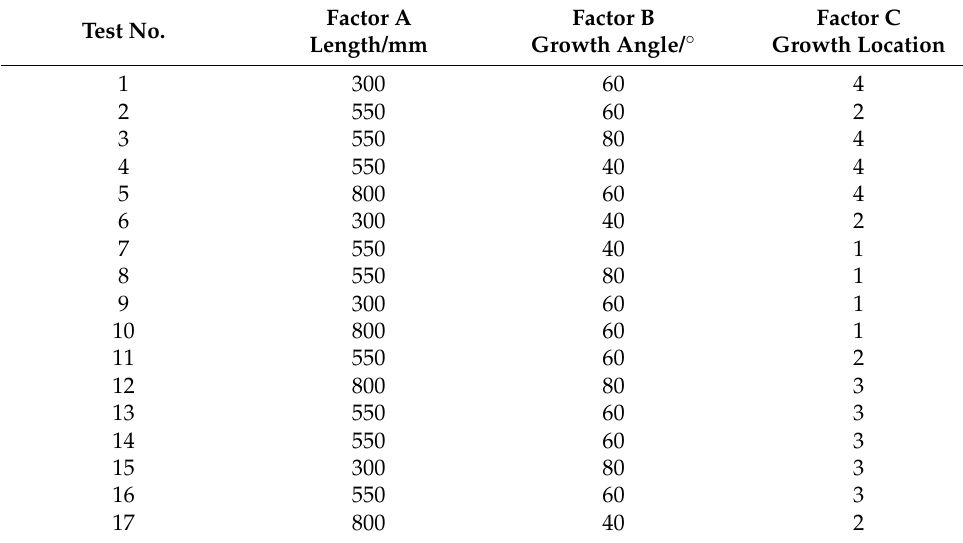
Table 2. Orthogonal test